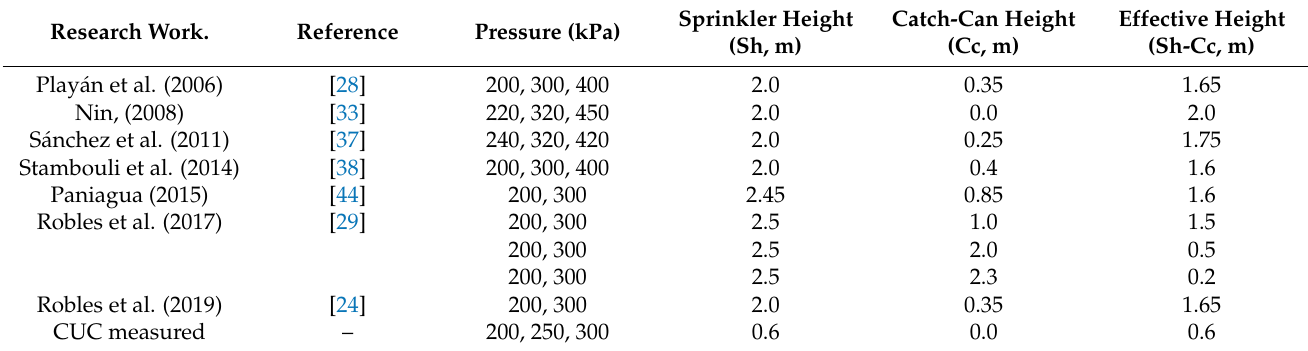
Table 3. Resume of the operating conditions and features of the different research